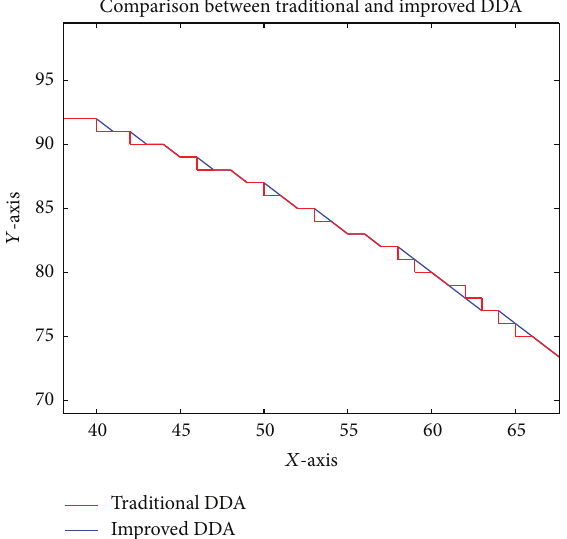
Figure 10: Excellent performance of improved DDA algorithm.